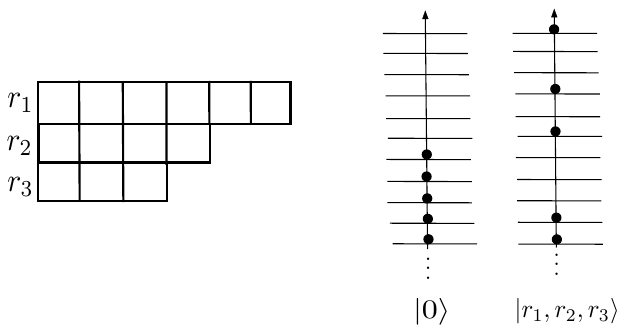
Figure 1 . (Left) A sample Young tableau with row-lengths ( r represent excitation energies of the fermions with respect to the